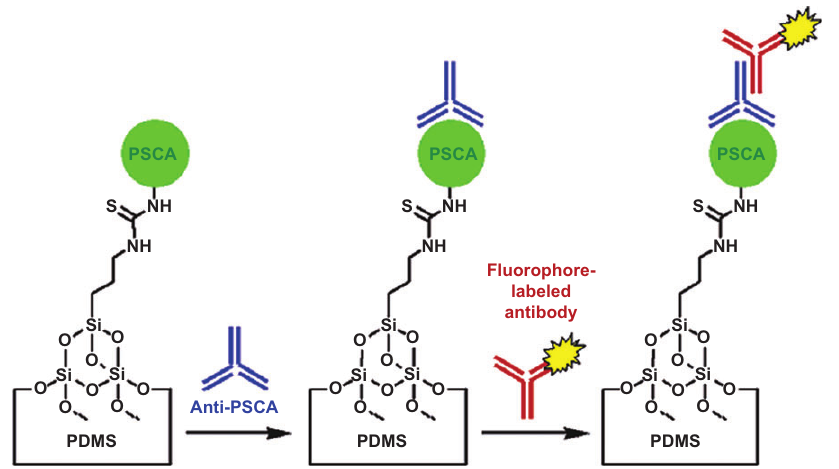
Figure 7 Schematic representation of the immunoassay for detecting and quantifying anti-PSCA using PSCA-grafted microchannels (Sui et al. 2006